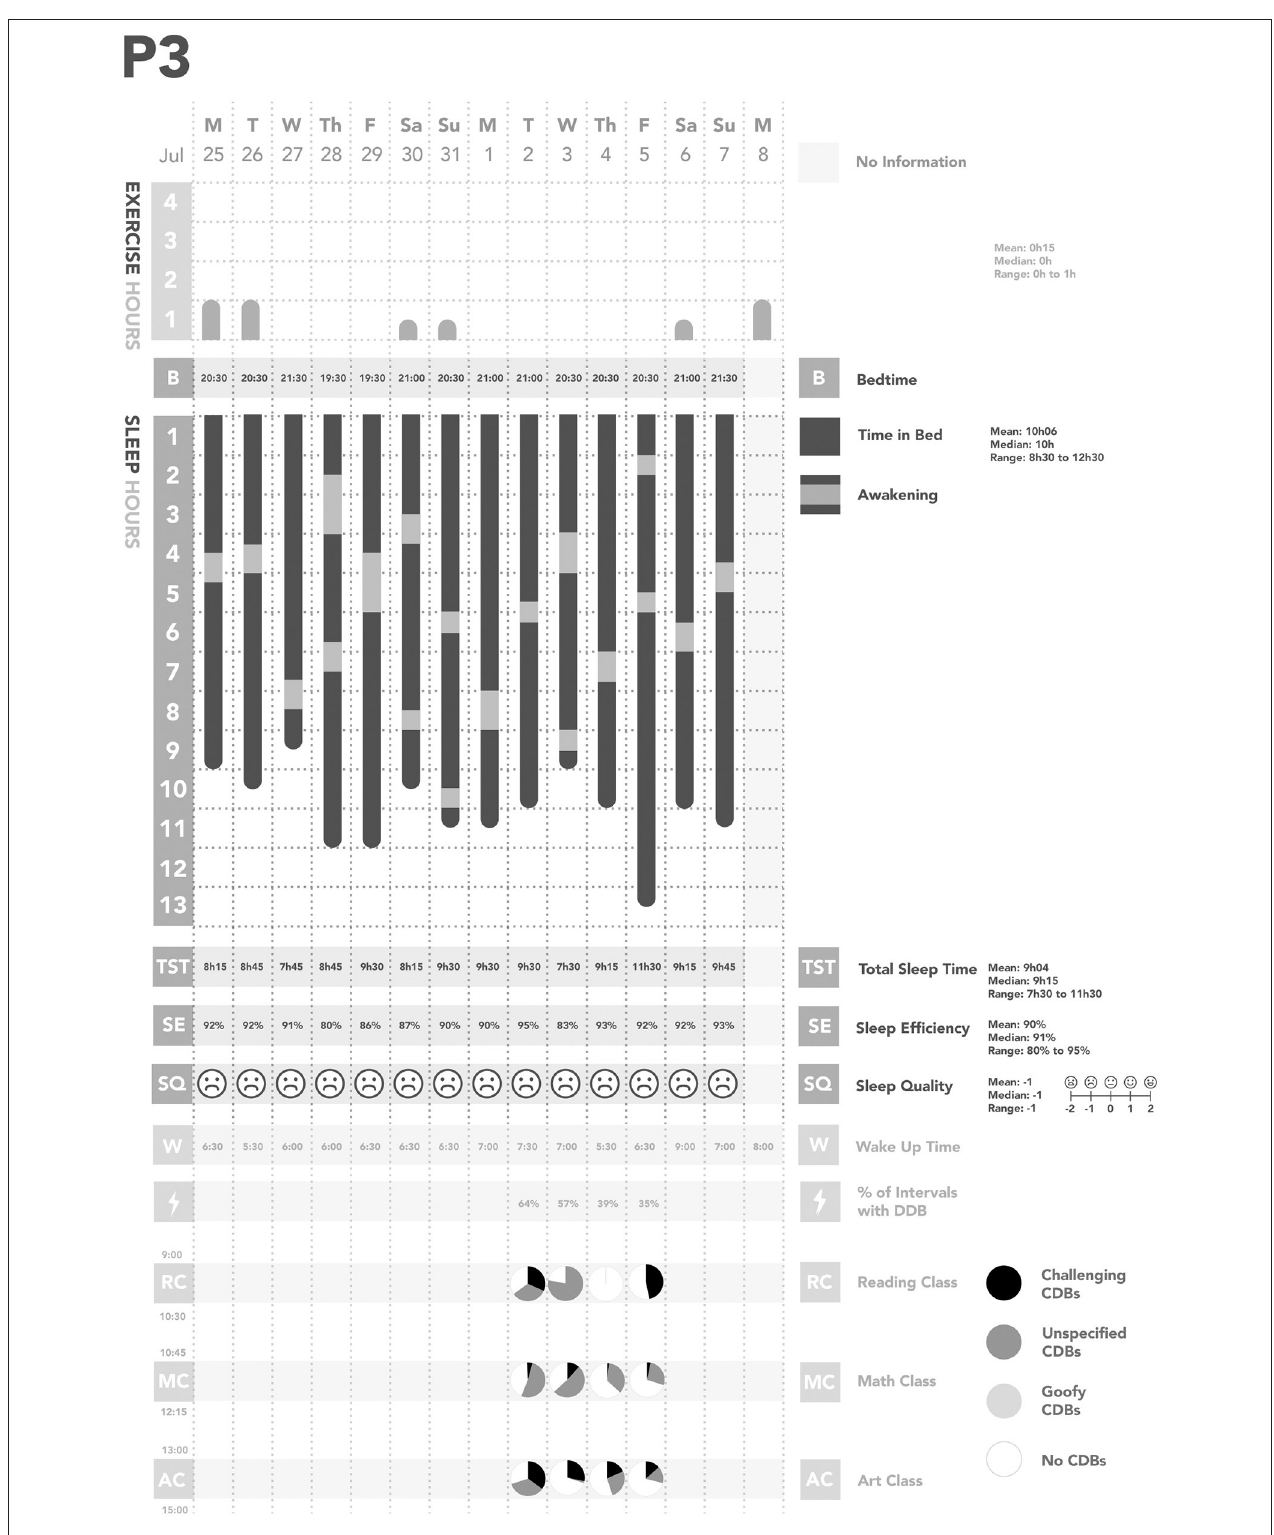
FIGURE 3 | Summary of Participant 3 (P3)’s data. CDBs, Challenging and/or disruptive behaviors.